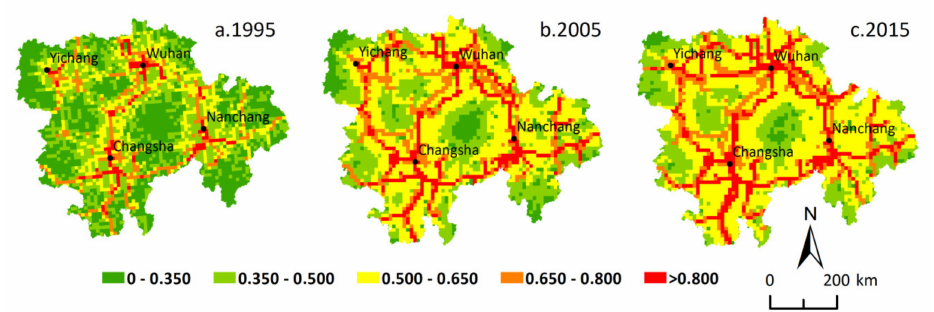
Figure 4. Spatial distribution of traffic accessibility in the Middle Reaches of the Yangtze River Urban Agglomerations at 5 km grid scale.